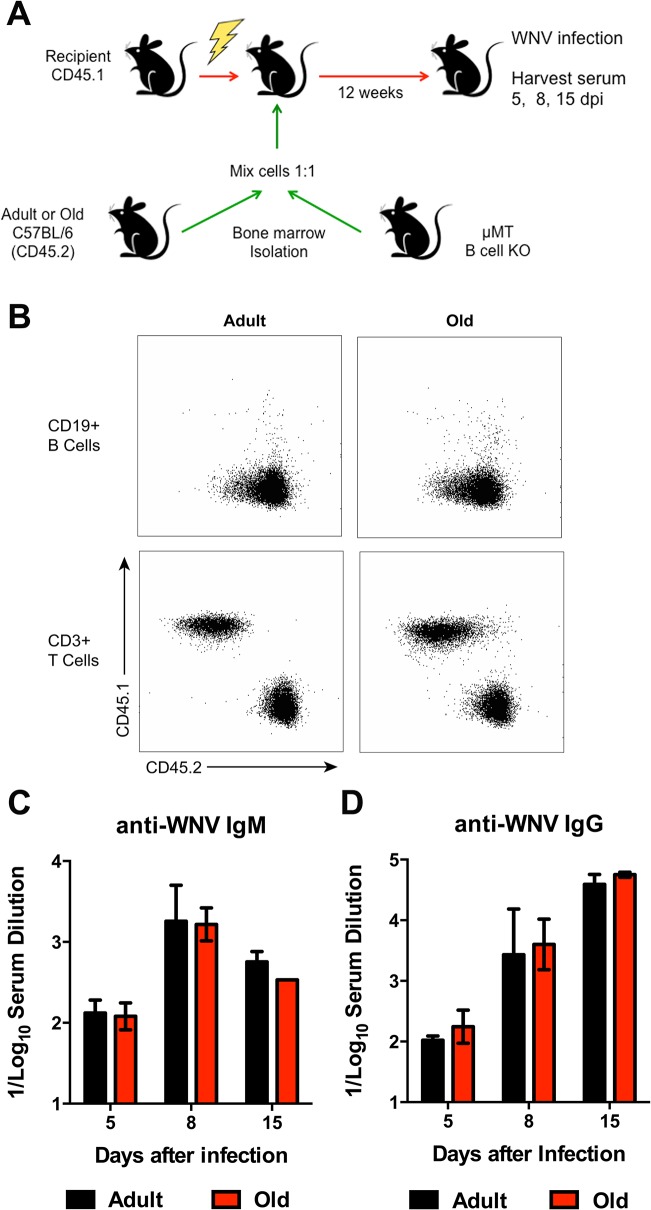
Humoral immune response of donor bone marrow into irradiated recipient mice.
A. Scheme of reconstitution studies with bone marrow from adult or old mice. 107 bone marrow cells from adult or old mice were mixed with 107 bone marrow cells from μMT (B cell deficient) mice and transferred into irradiated recipient CD45.1 mice. After 12 weeks, mice were infected with WNV (New York strain) and serum was harvested 5, 8, and 15 dpi. B. After 12 weeks post transfer, blood was sampled and tested for reconstitution efficiency. The vast majority (>95%) of circulating CD19+ B cells was derived from the CD45.2 donor mice. C-D. IgM (C) and IgG (D) levels were measured by ELISA for reactivity with WNV E protein. Data is plotted as the reciprocal log10 titer and represents data from 5 mice per group.